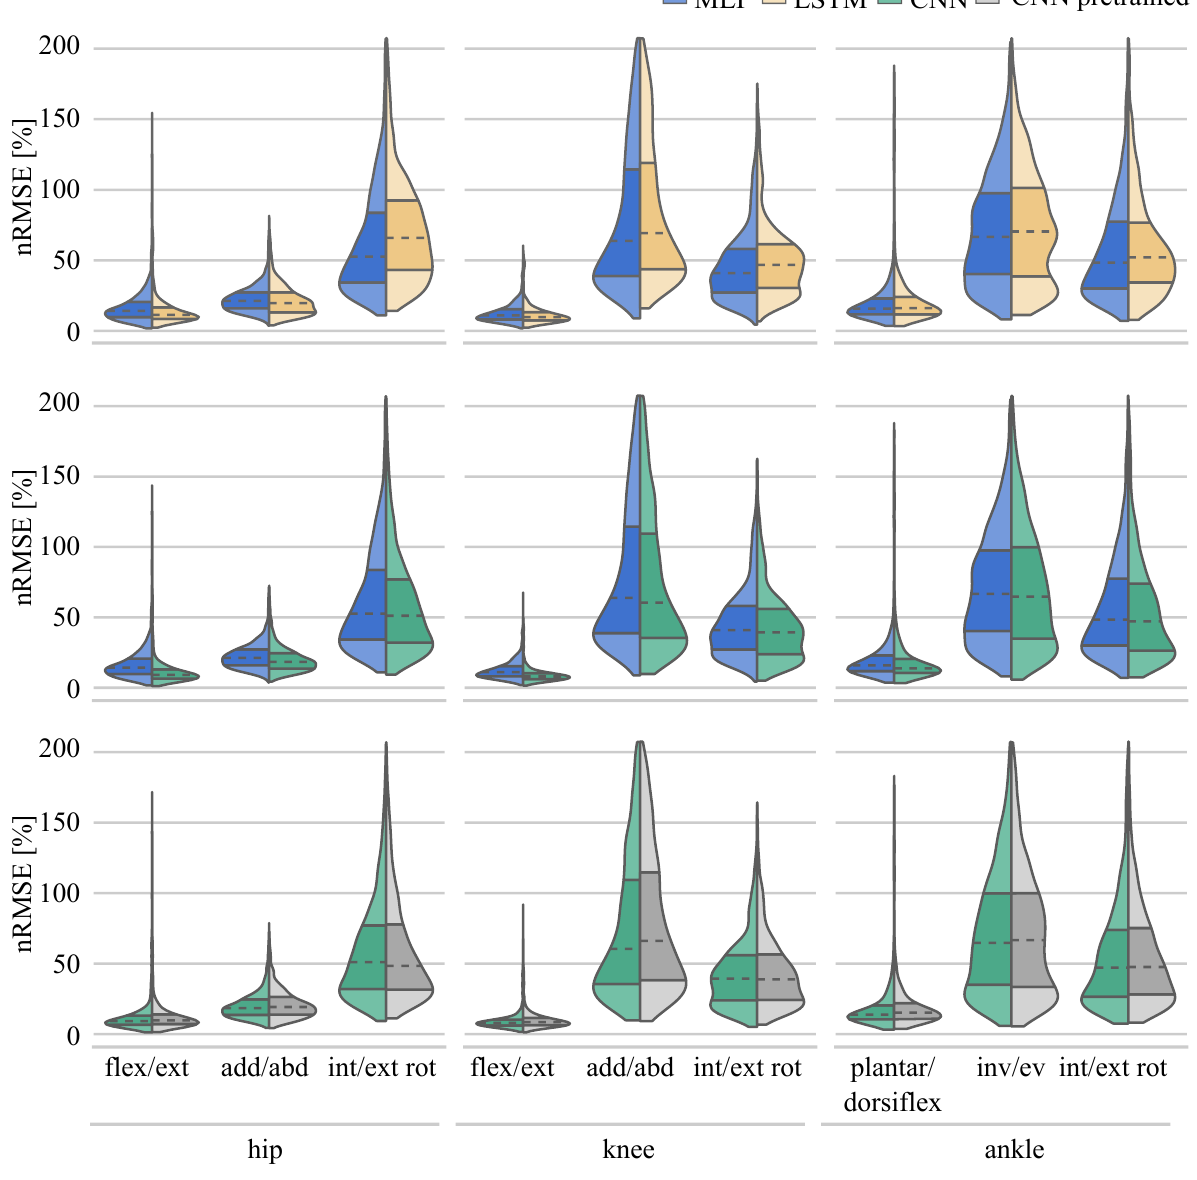
Figure 6. Distribution of the nRMSE values for the joint angle prediction. When considering joint kinetic prediction ANN performance, overall the LSTM per- formed slightly worse ( − 1.73%) than the MLP network. On closer examination, the LSTM outperformed the MLP on the prediction of hip flexion-extension and adduction-abduction moments, knee adduction-abduction moments and ankle plantar-dorsiflexion moments. The CNN overall performed nearly ten percent better than the MLP (9.63%). Only for the prediction of ankle inversion-eversion moments the CNN did not outperform the MLP. Overall, using a pretrained CNN did not result in a better joint moment prediction per- formance than a CNN trained from scratch ( − 2.80%), with only ankle inversion-eversion moments using a pretrained CNN reporting superior prediction results (Table 2, Figure